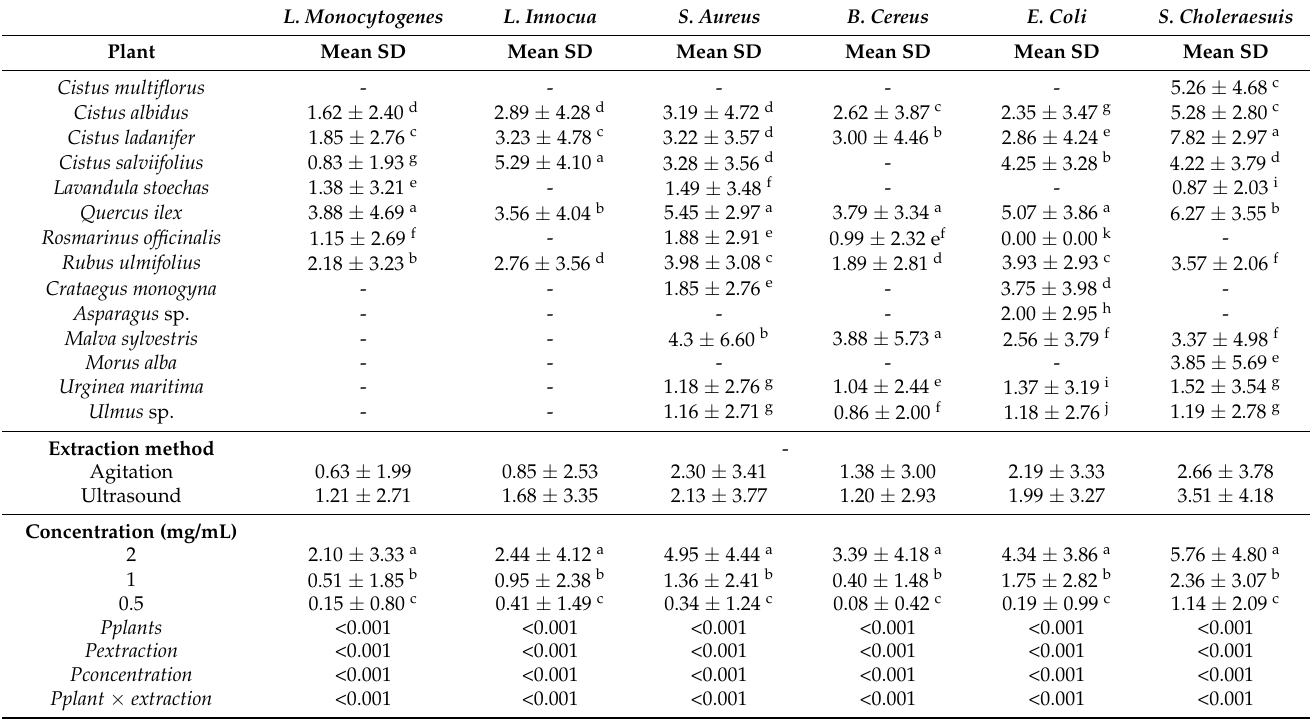
Table 3. Diameter of inhibition zones in mm of different concentrations of plant extracts tested that showed activity against